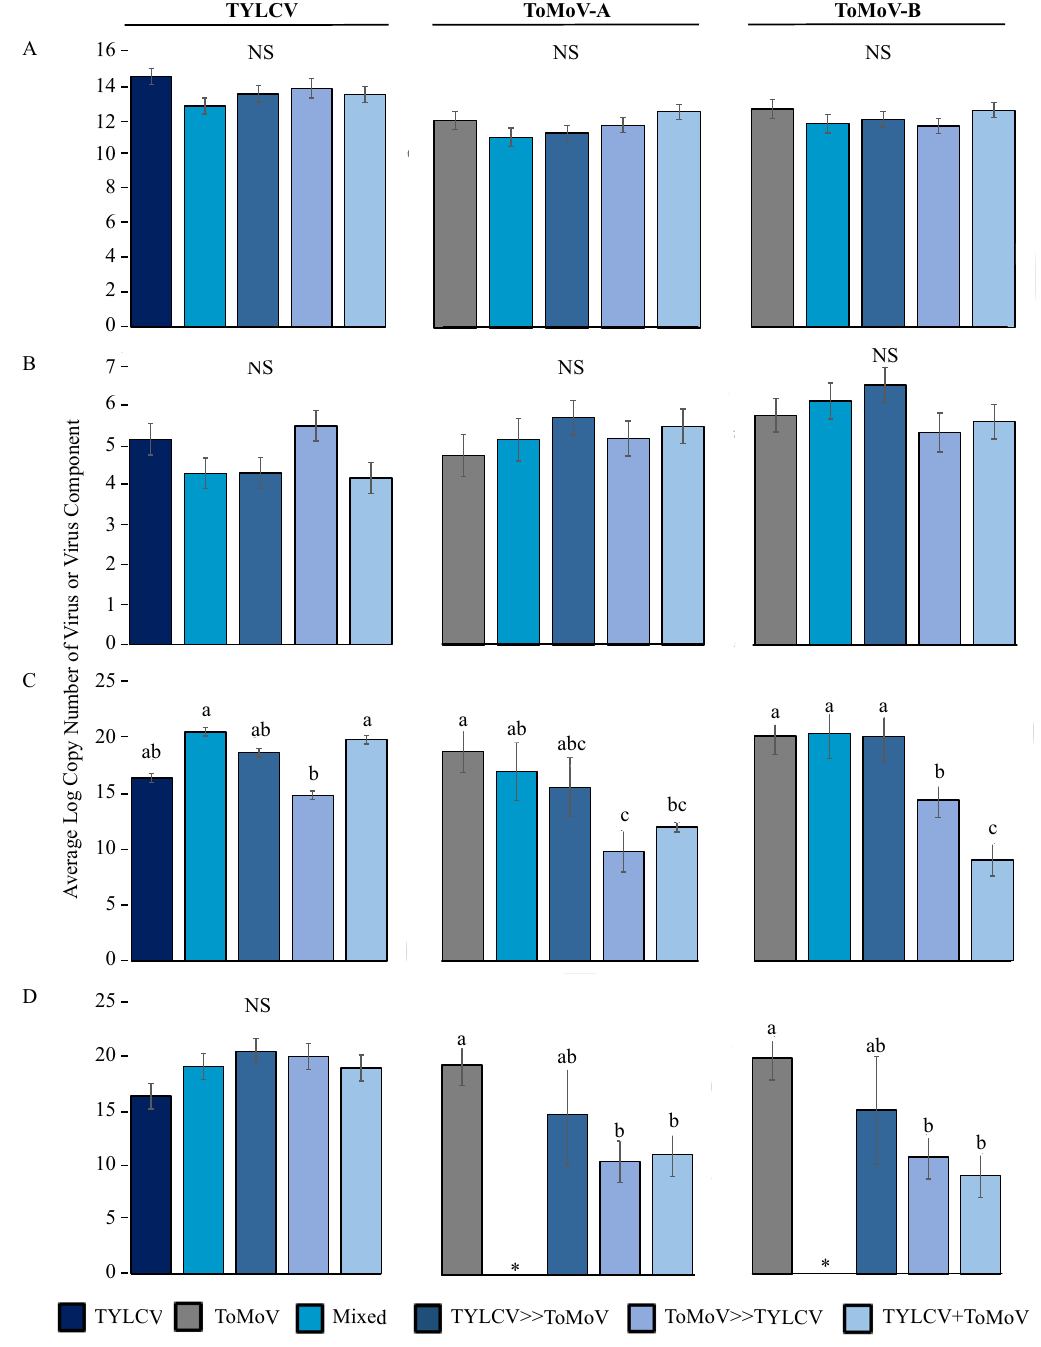
Figure 1. The average log 10 copy number of TYLCV, ToMoV-A, and ToMoV-B were quantified and analyzed separately in ( A ) vector cohorts; ( B ) artificial diet viruliferous vector cohorts fed on ( C ) singly infected plants (TYLCV or ToMoV treatments) and plants co-infected after vector inoculation in co-infection scenario treatments (Mixed, TYLCV»ToMoV, ToMoV»TYLCV, TYLCV + ToMoV), and ( D ) singly infected plants and vector-(co-)inoculated singly-infected plants (VCSIPs). *No single infections of ToMoV occurred as VCSIPs in the Mixed treatment. Copy numbers were compared for the main effects of virus acquisition scenario treatment, virus or viral component, and their interaction term; averages from interaction term main effects are shown. LS means comparisons were conducted using Tukey’s method at P = 0.05. NS represents that the interaction term in the model was not